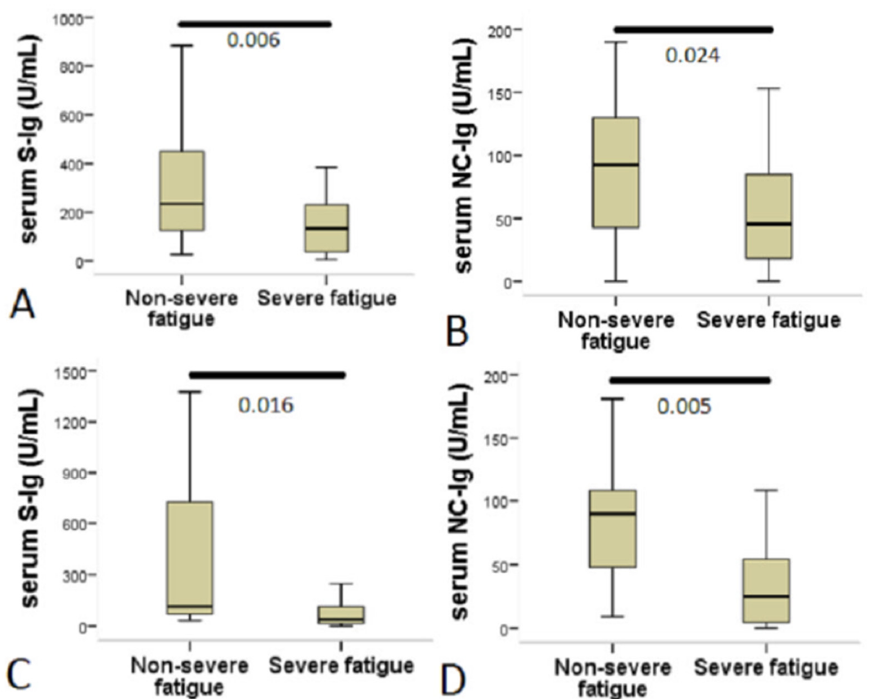
Figure 2. Patients with severe fatigue showed decreased serum anti-SARS-CoV-2 antibody levels.